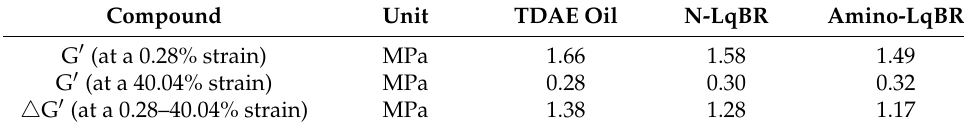
Figure 4. Payne effect of carbon black masterbatches. Table 5. G ′ values according to the processing aids applied to the compounds.